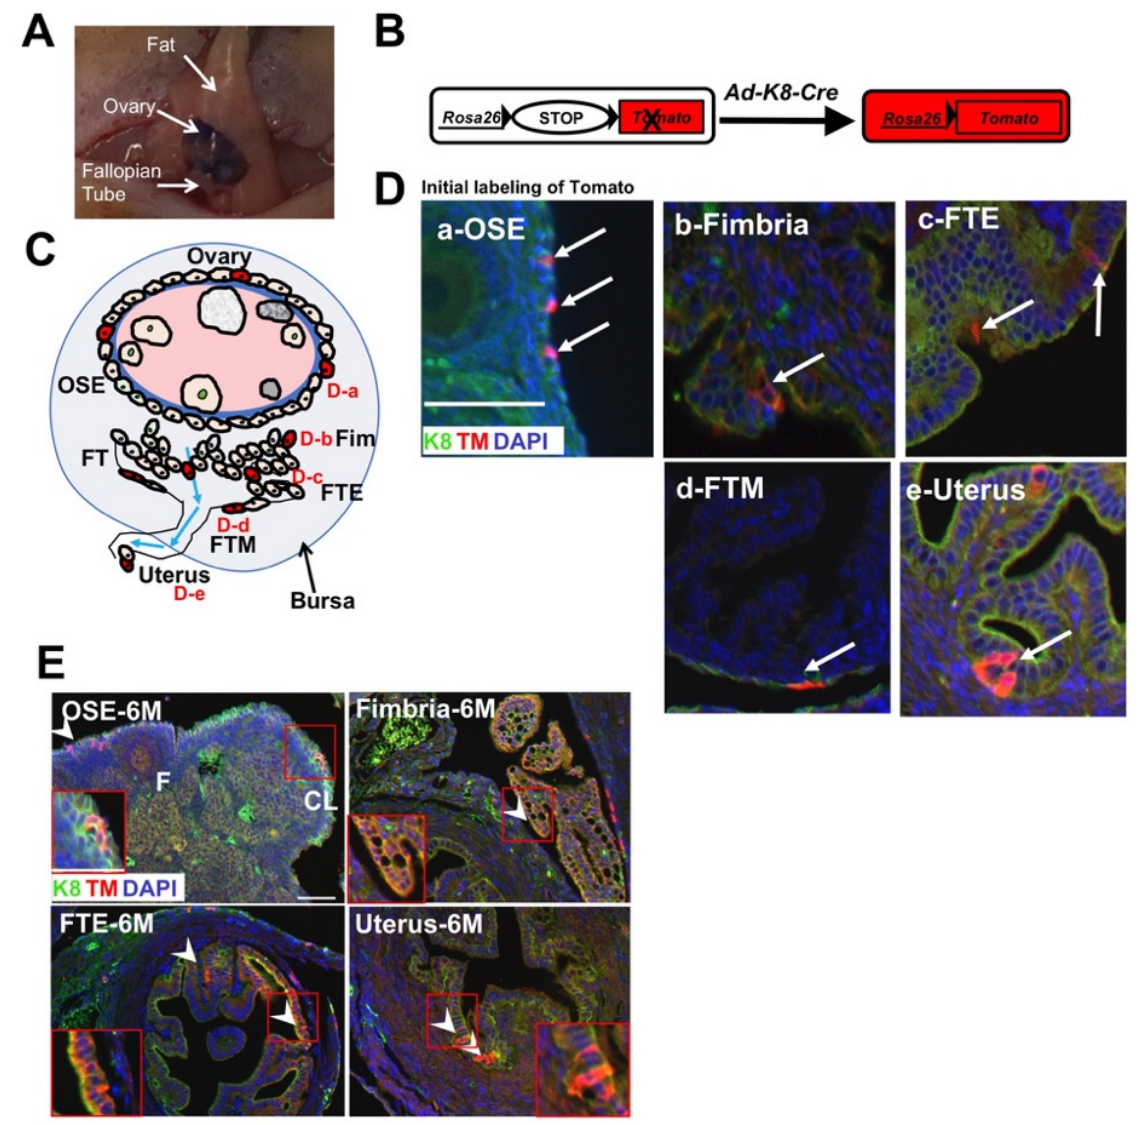
Figure 1. Ad-K8-Cre targets mesothelial and Müllerian-derived epithelial cells. ( A ) Mouse ovary and associated tissues are shown as an example of intrabursal injection (with Trypan blue). ( B ) Schematic diagram showing the activation of the Tomato reporter from the R26tdTm allele upon Cre expression from the Ad-K8-Cre virus. X for Tomato on the left right indicates that the Tomato reporter is initially silenced. ( C ) Graphical diagram showing expected cells infected by Ad-K8-Cre upon intrabursal injection. Staining data are shown in ( D ). OSE: ovarian surface epithelium; Fim: Fimbria; FTE: fallopian tube epithelium; FTM: Fallopian tube mesothelium. ( D ) Representative images of the ovary ( a ), fallopian tube ( b – d ), and uterus ( e ) from R26tdTm female mice showing K8, Tomato (TM) (arrows, indicating Tomato + cells), and DAPI staining 2 weeks after Ad-K8-Cre intrabursal injection. F: follicle. Scale bar = 50 µ m. ( E ) Representative images of the ovary, FT, and uterus from R26tdTm reporter mice six months (6 M) after intrabursal injection of Ad-K8-Cre , showing K8, Tomato (TM, as a lineage tracing marker), and DAPI staining. Arrowheads indicate Ad-K8-Cre -infected cells and/or their progeny (upon tracing, TM + ). F: follicle; CL: corpus luteum. Scale bar (applies to all pictures in the same Figure panel) = 50 µ